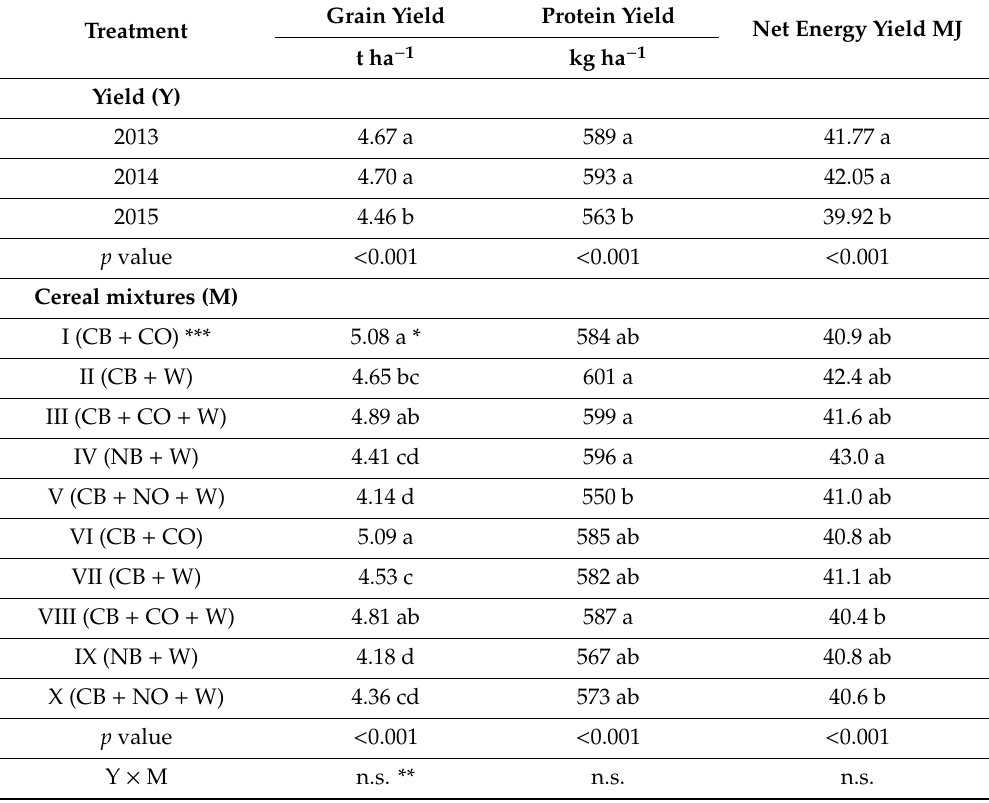
Table 8. Yield of various spring cereal mixtures on Haplic Arenosols.